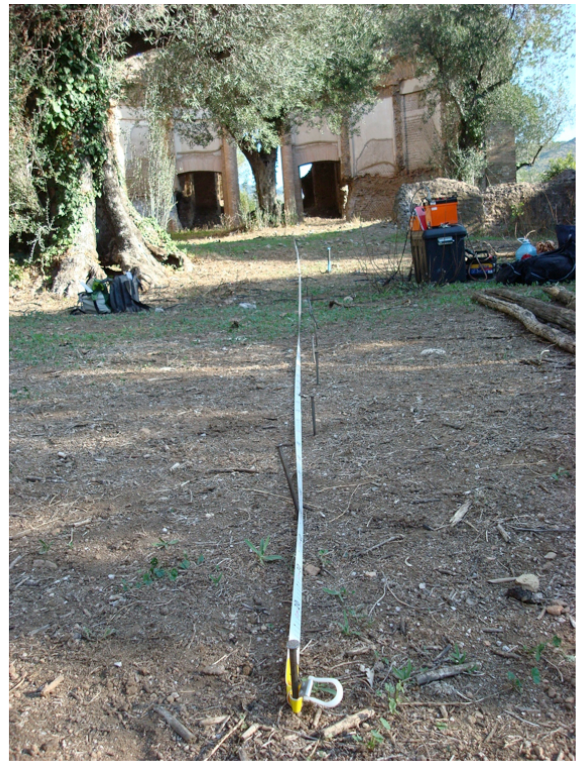
Fig. 15. Measurement n. 15 and the Apollo’s Temple in the background (see plan Fig. 10) (photo A. M. Marras).